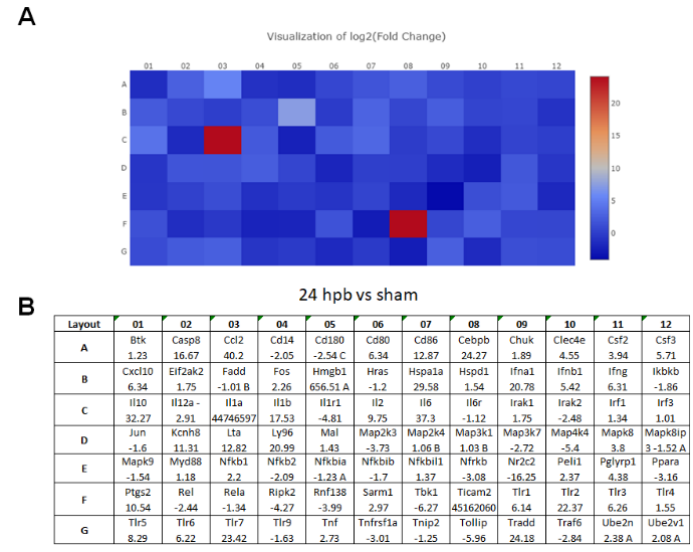
Figure 2. ( A )Heat maps of real-time RT 2 Profiler PCR Array showing differential expression of 84 TLR-related genes stimulated by burn injury. ( B ) The ≥ 1.5-fold changes represent the genes that are up-regulated, and the ≤− 1.5-fold changes represent the genes that are down-regulated by burn injury.